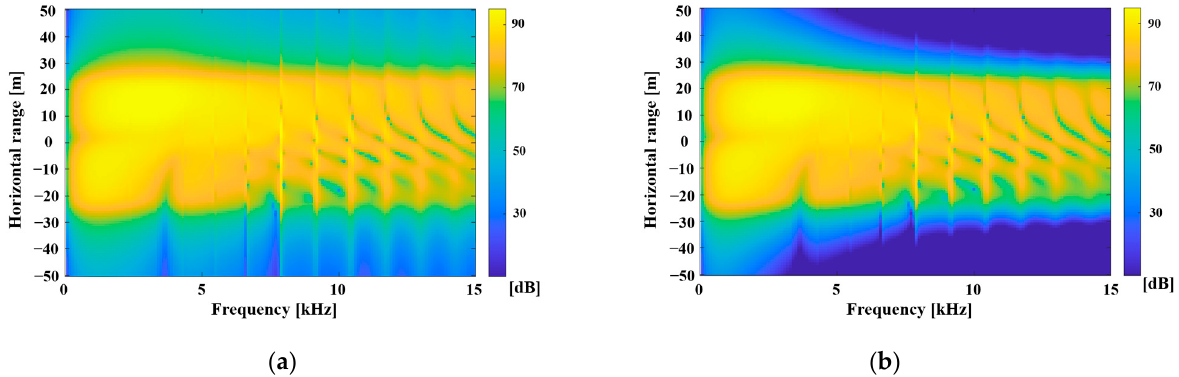
Figure 6. Scattered signals of moving receivers along horizontal range from − 50 to 50 m at fixed depth of 10 m from the bottom ( a ) without and ( b ) with attenuation.